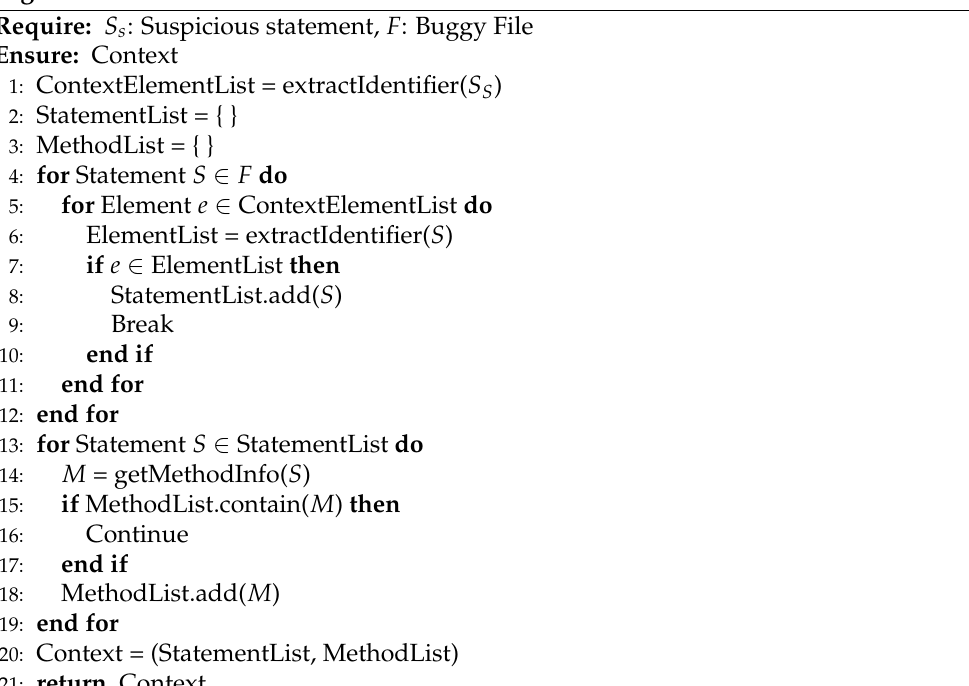
Algorithm 1 Context